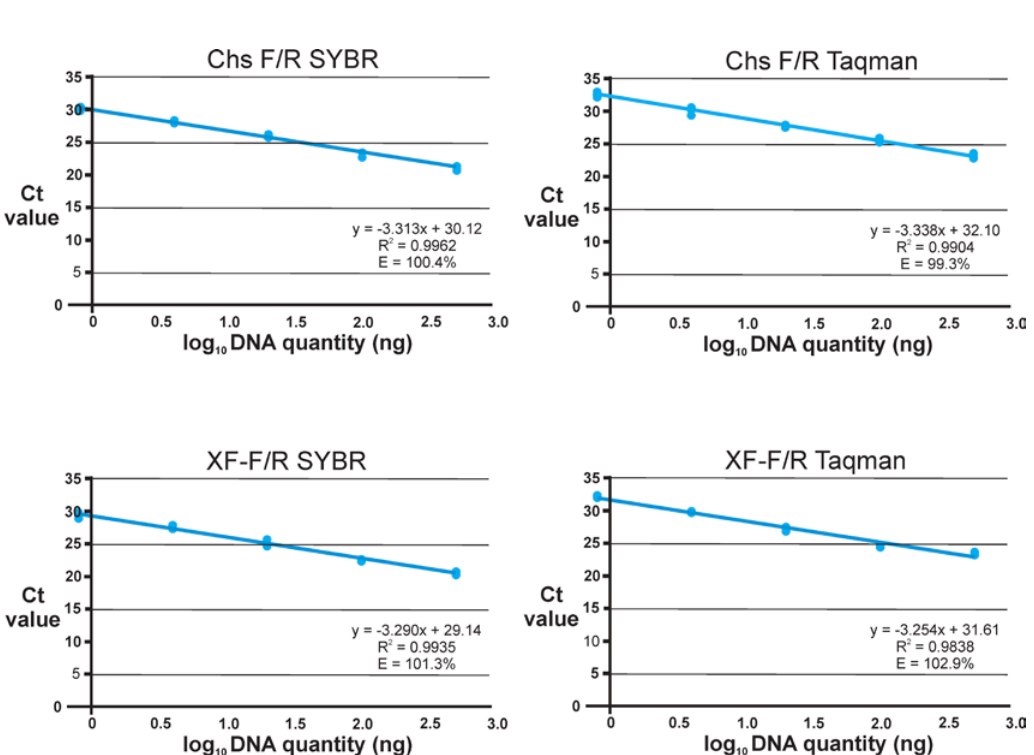
Figure 1. Real-time PCR standard curve graphically represented as a semi-log regression line plot of CI value (Y-axis) vs. log of input nucleic acid (X-axis). Five serial dilutions of DNA (extracted from 1 g of leaf petioles) between the range of 500 and 0.8 ng were used to design the standard